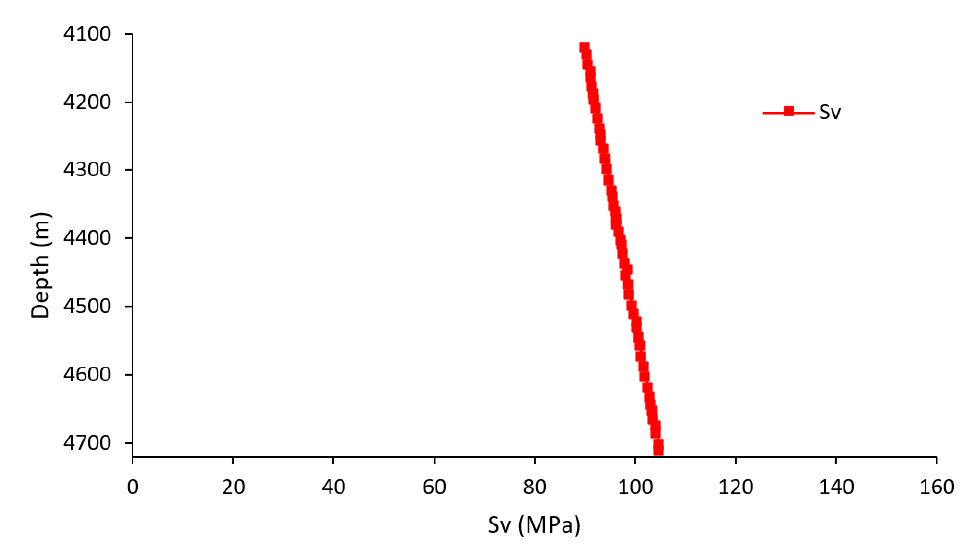
Figure 11. Wellbore-D wall minimum horizontal stress in the Azar oilfield, collapsed in azimuth 120° and 300°. This rose diagram result was made with windrose.xyz.